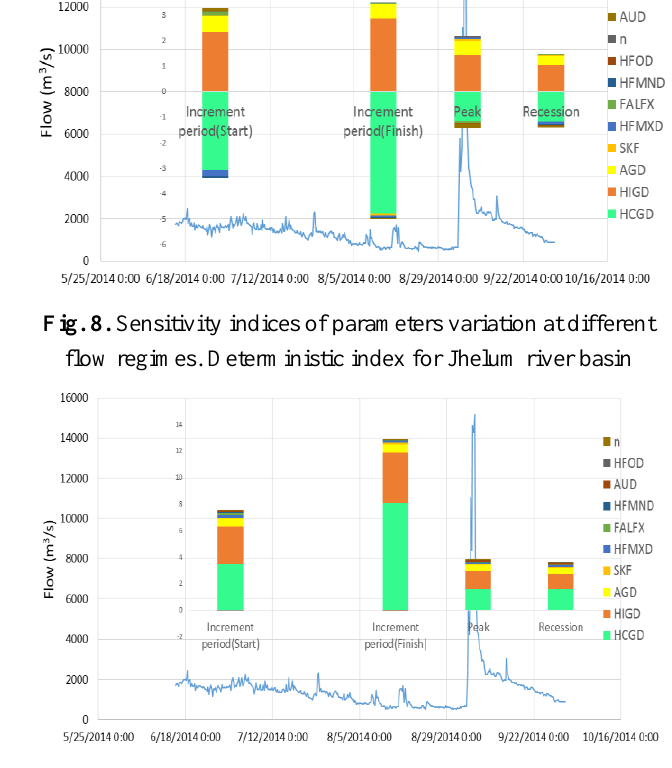
Fig. 9. Sensitivity indices of parameters variation at different flow regimes. Amplification factor for Jhelum river